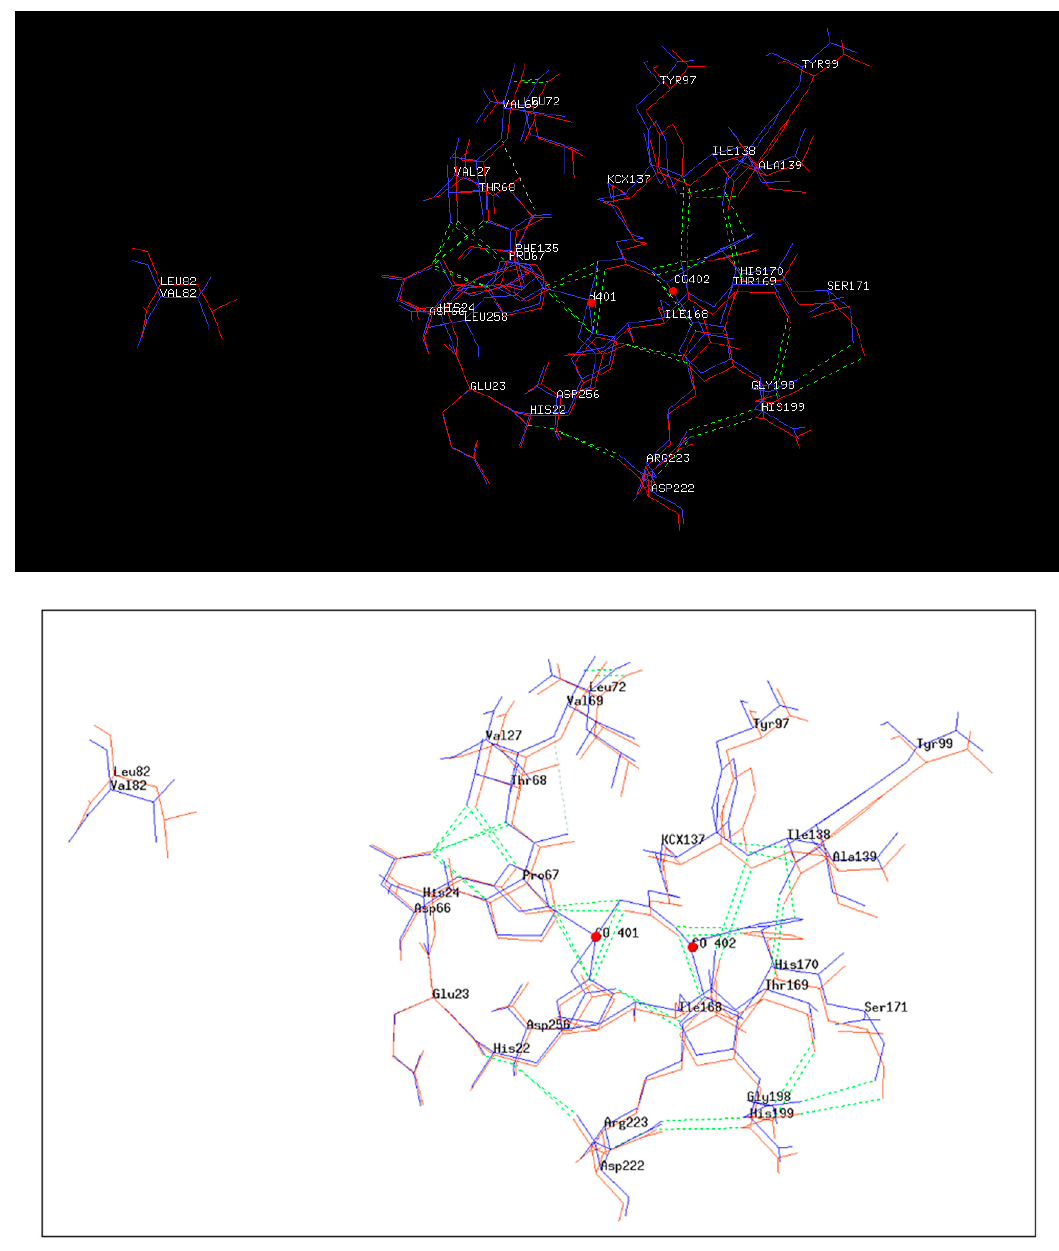
Figure 6. Details of the actives sites. In Figure 6 details of residues (stick representation) of the active sites of 3Mut (blue) and 4Mut (red) are given. Residues within 8 A from CX of K137 are displayed. The Co 2+ ions in 4Mut are shown as red spheres.